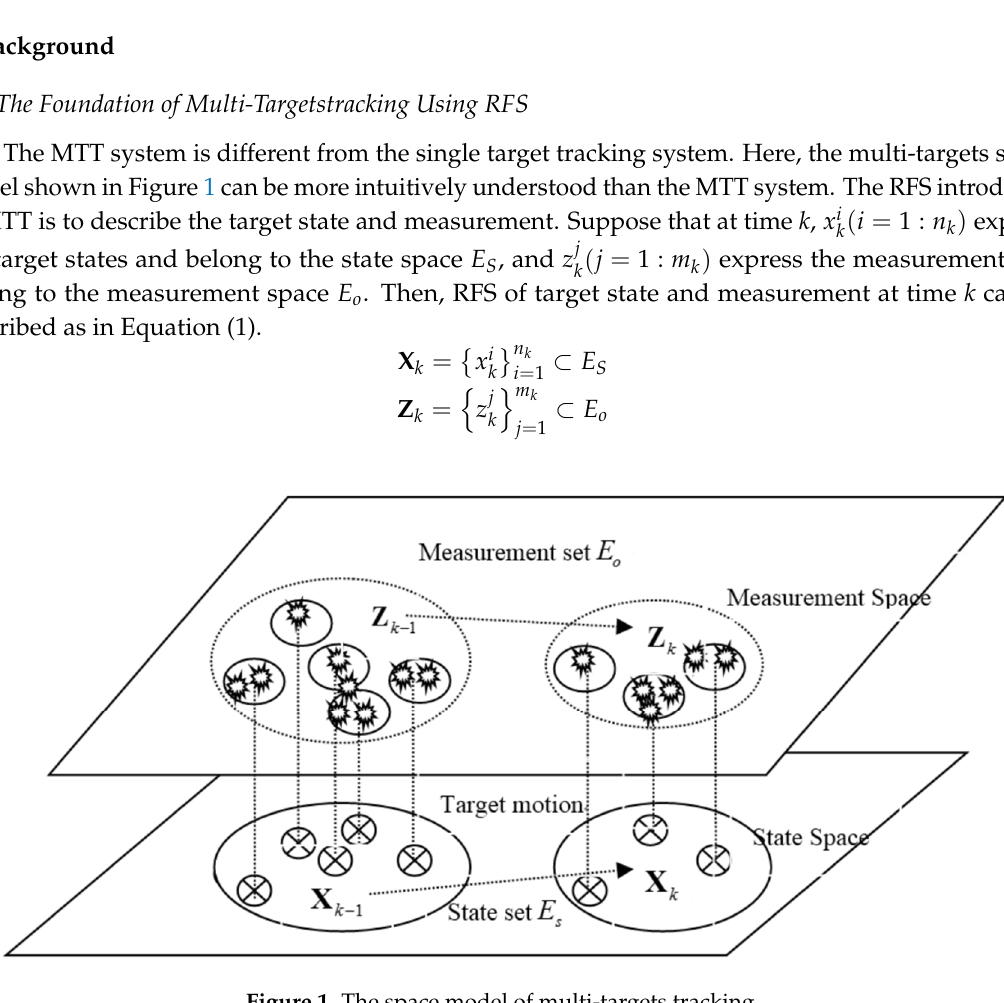
Figure 2. Relationship between Probability Hypothesis Density (PHD) and Gaussian Mixture Probability Hypothesis Density (GM ‐ PHD).